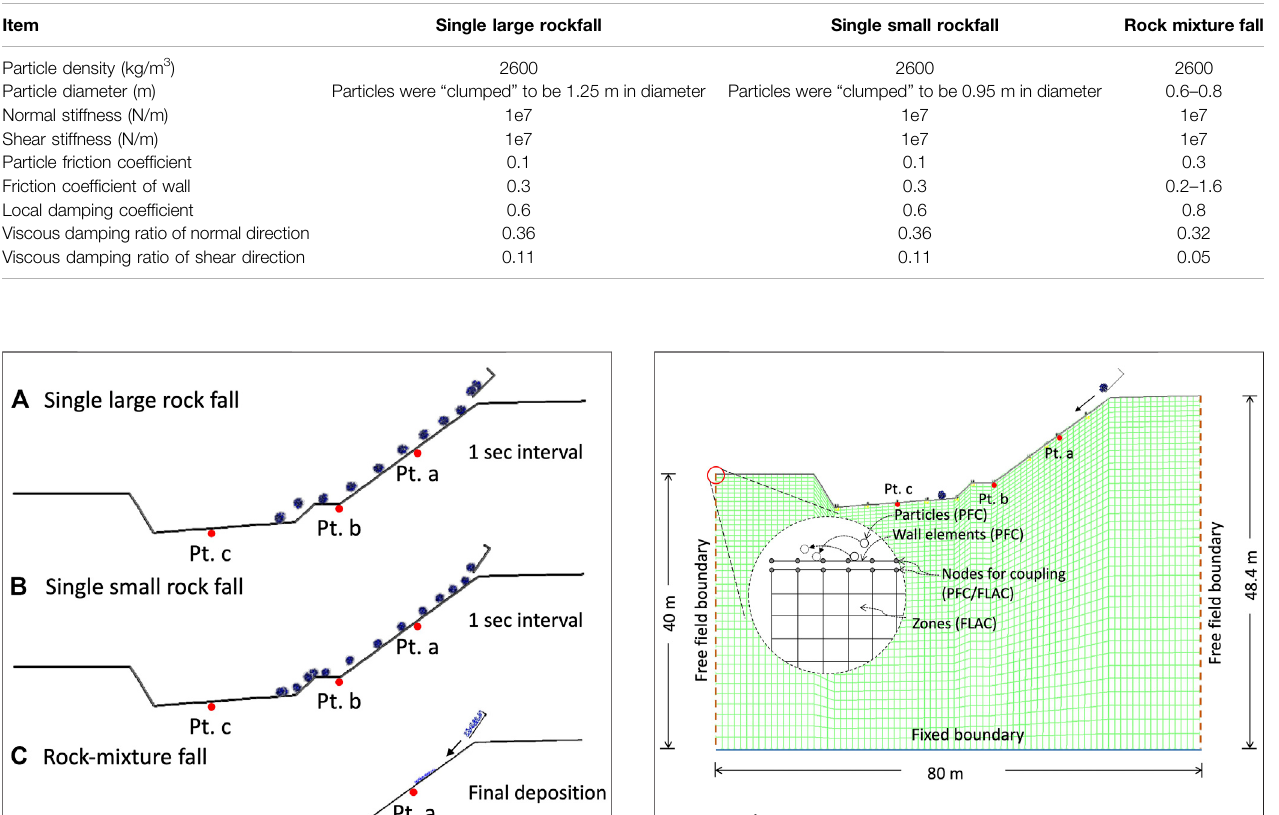
FIGURE 4 | Schematic plots of the PFC and FLAC coupling